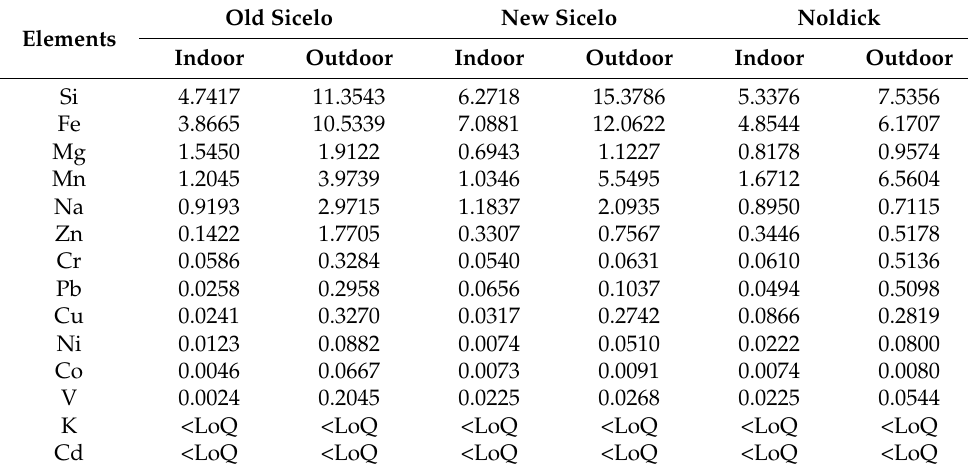
Table 4. Indoor and outdoor elemental concentrations ( µ g/m 3 ) in the air across the three residential areas. Old Elements